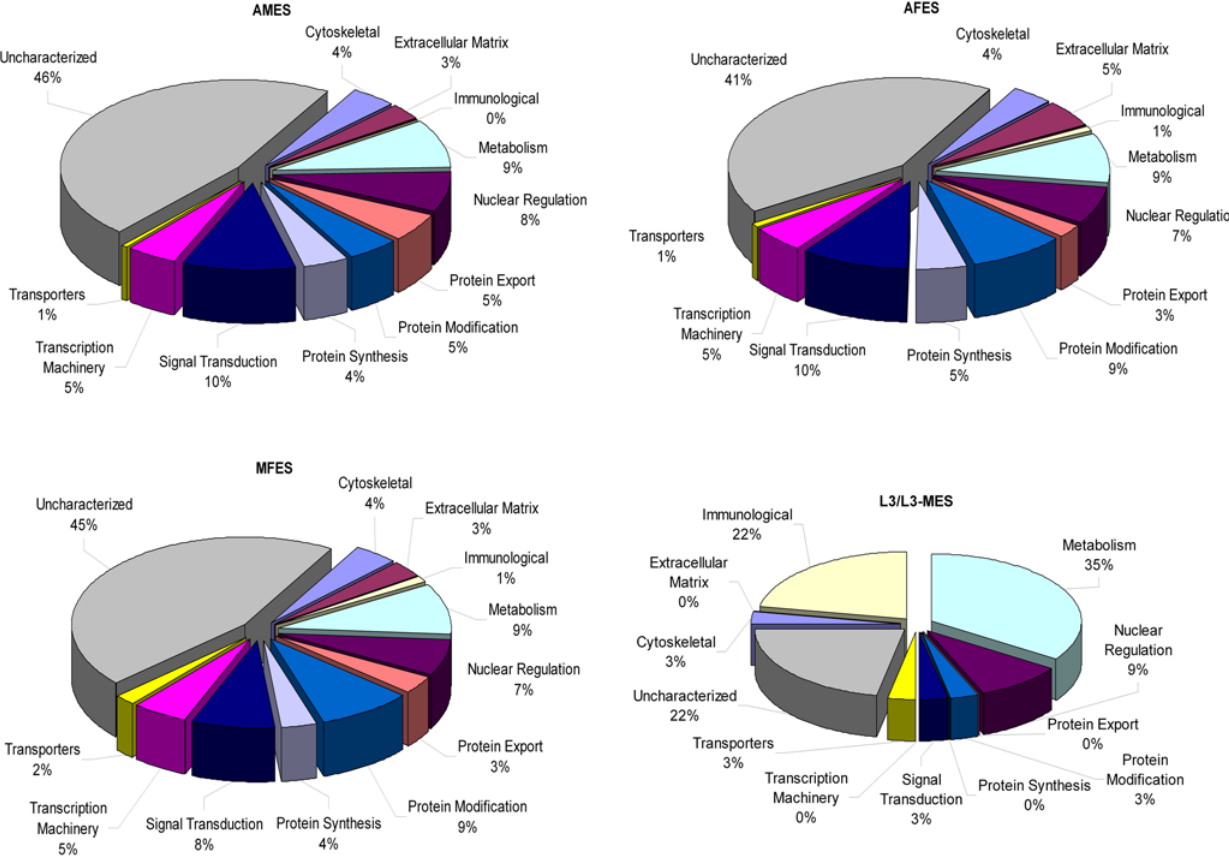
Figure 3. Stage specific functional profiles of Brugiamalayi ES proteins. Pie-charts representing percentage of proteins identified from each of the stages, plotted based on their functional classification. Only a single annotation was assigned to a given protein. All unknown and hypothetical proteins have been classified as uncharacterized. Note: Metabolism includes amino acid, carbohydrates, nuclear and energy metabolism). The complete list is given with additional annotation and embedded links in the Final Secretome-Web (http://exon.niaid.nih.gov/transcriptome/ Bm-secretome/Brugia-Secretome-Web.zip) version. AMES : Adult male ES; AFES : Adult female ES; MFES : Microfilariae ES; L3-ES: L3 larval ES; L3-MES:L3 larval molting ES.